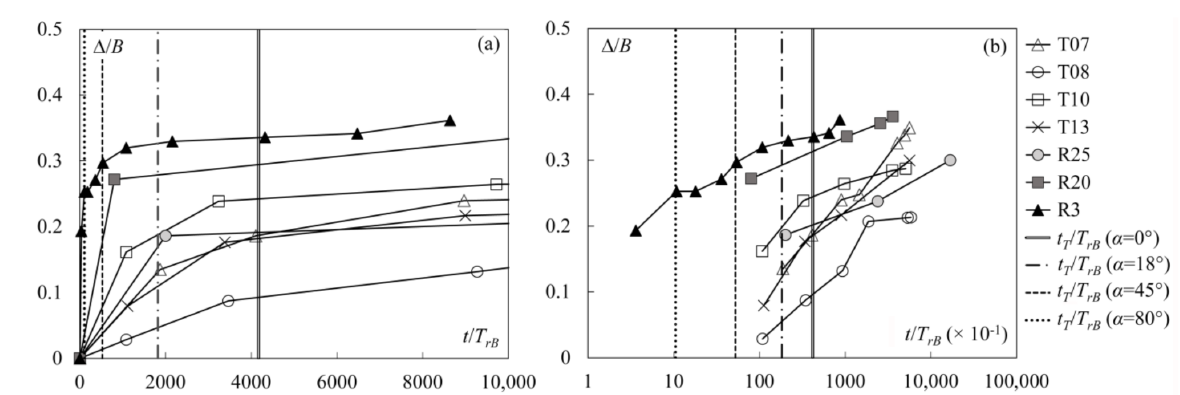
Figure 2. ∆ / B versus t / T rB for ( a ) t / T rB < 10,000 and ( b ) total test duration for tests T07, T08, T10 and T13 of Ben Meftah and Mossa [3] and tests R25, R20 and R3 of Ben Meftha and Mossa [26], along with the transition times calculated using Equation (3). Tests of Ben Meftah and Mossa [3] pertain to bed sills (for which we adopted α = 0 ◦ ). Tests of Ben Meftah and Mossa [26], pertain to grade-control structures with inclined downstream surface for which we adopted α = 18 ◦ (Run R25), 45 ◦ (R20), and 80 ◦